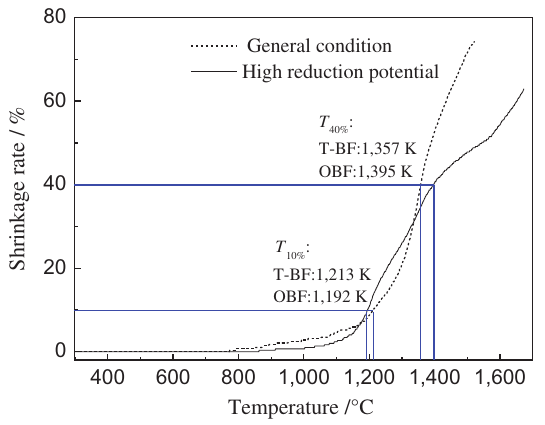
Figure 5: Shrinkage rate – temperature curve of pellet in general condition and high reduction potential condition.